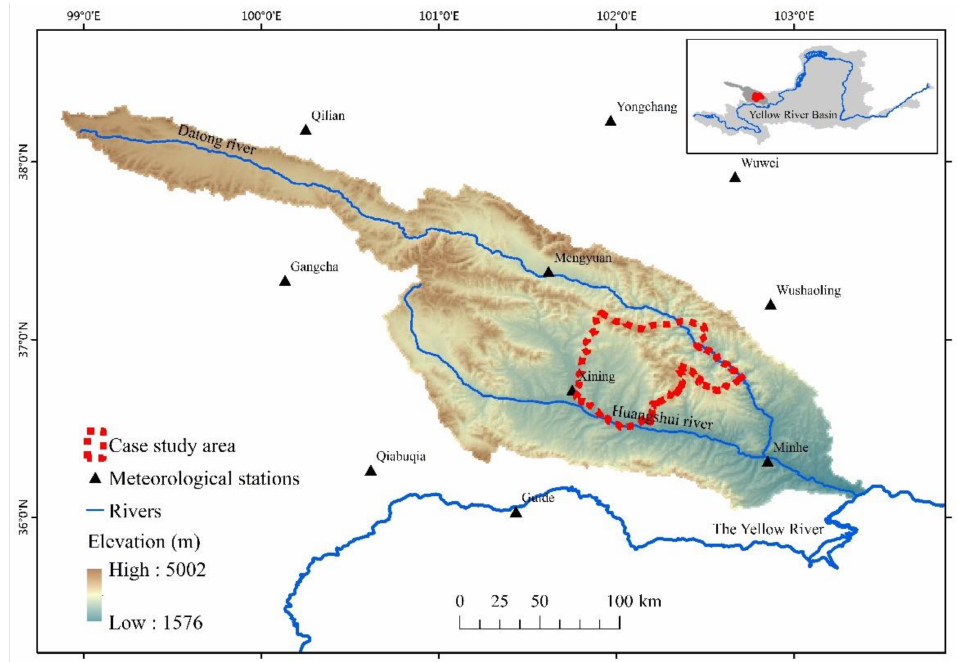
Figure 1. The case study